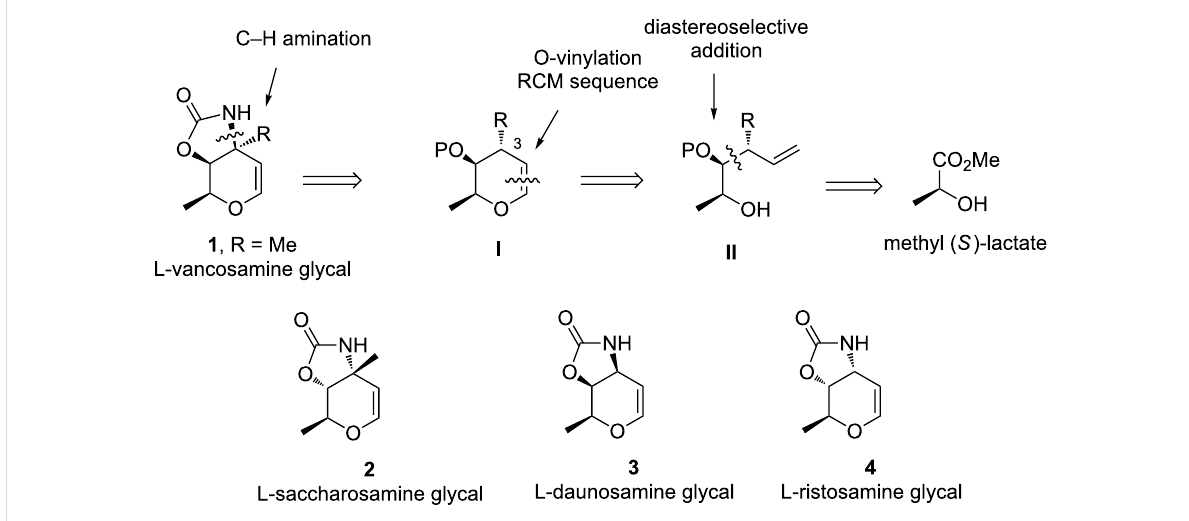
Figure 3: Strategy including a ring-closing metathesis of vinyl ethers as key step for the preparation of several carbamate-protected 3-aminoglycals.